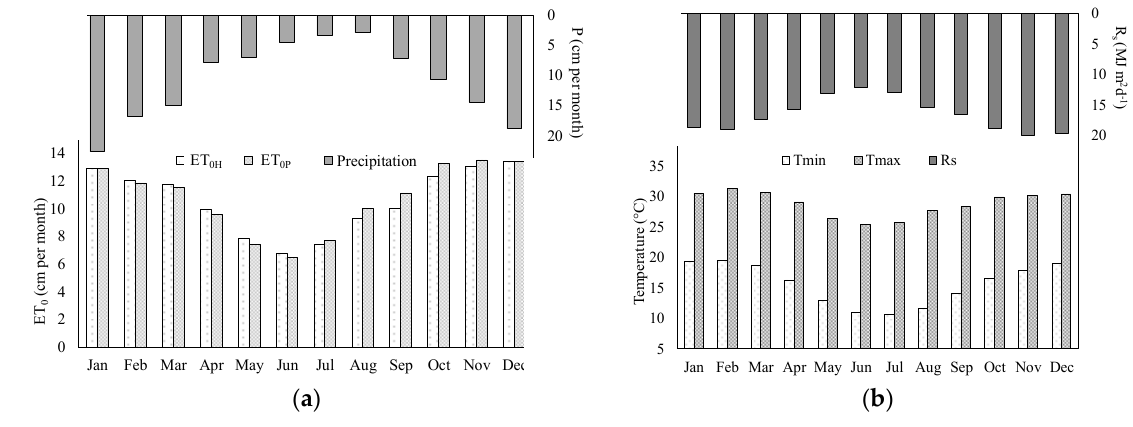
Figure 2. Average monthly reference evapotranspiration (ET 0 ) predicted by the calibrated Hargraves equation (ET 0H ) and the Penman–Monteith equation (ET 0P ), precipitation (P) ( a ); and maximum and minimum temperature (T max and T min ) and solar radiation (R s ) ( b ) for the University of São Paulo weather station in Piracicaba (SP), Brazil.